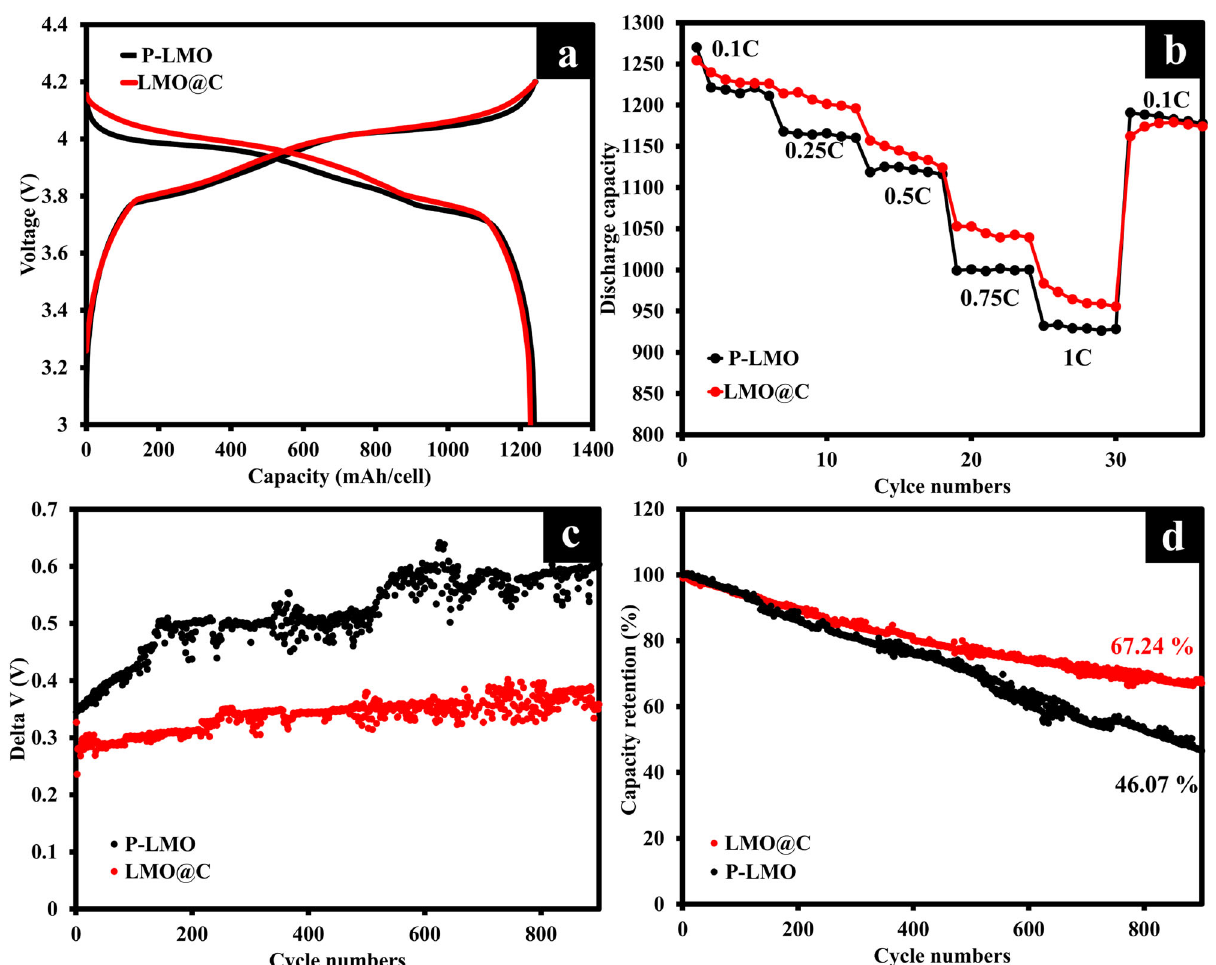
Fig. 4 Electrochemical performances of cylindrical 18650 P-LMO//graphite and LMO@C//graphite cells. a Galvanostatic charge/discharge pro fi les of P-LMO and LMO@C cells. b Rate-capability of P-LMO and LMO@C cells. c Delta V vs. cycle of P-LMO and LMO@C cells. d Cycling stabilities of P-LMO and LMO@C